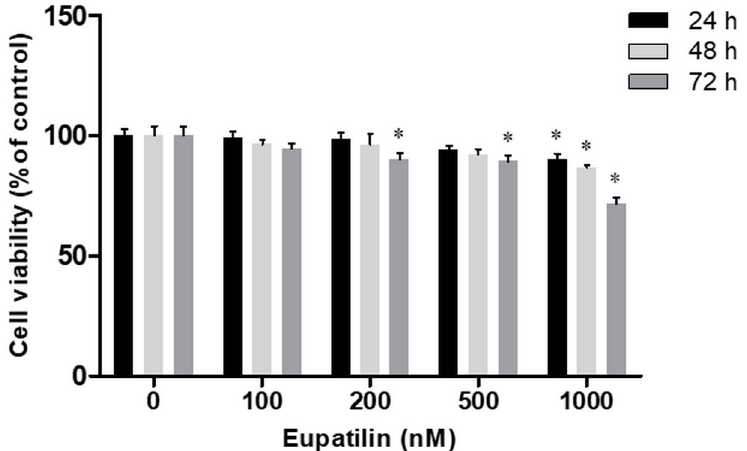
Fig 1. Effect of eupatilin on cytotoxicity in human vocal fold fibroblasts (hVFFs). The cells were incubated with eupatilin for the indicated times and at the indicated concentration. The viability of the hVFFs was then measured in a MTT assay. Data are representative of three independent experiments performed in triplicate and are expressed as the mean ± standard error of the mean (SEM). � p < 0.05 vs. untreated control (eupatilin = 0 nM).